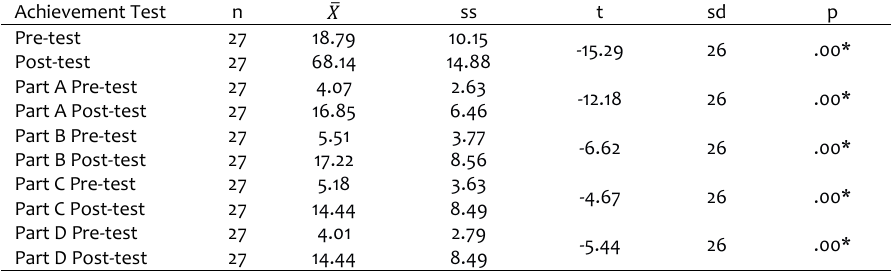
Table 6. The results of the Dependent Samples t-Test regarding the comparison of the pre-test and post-test mean scores of the Group Story Achievement Test